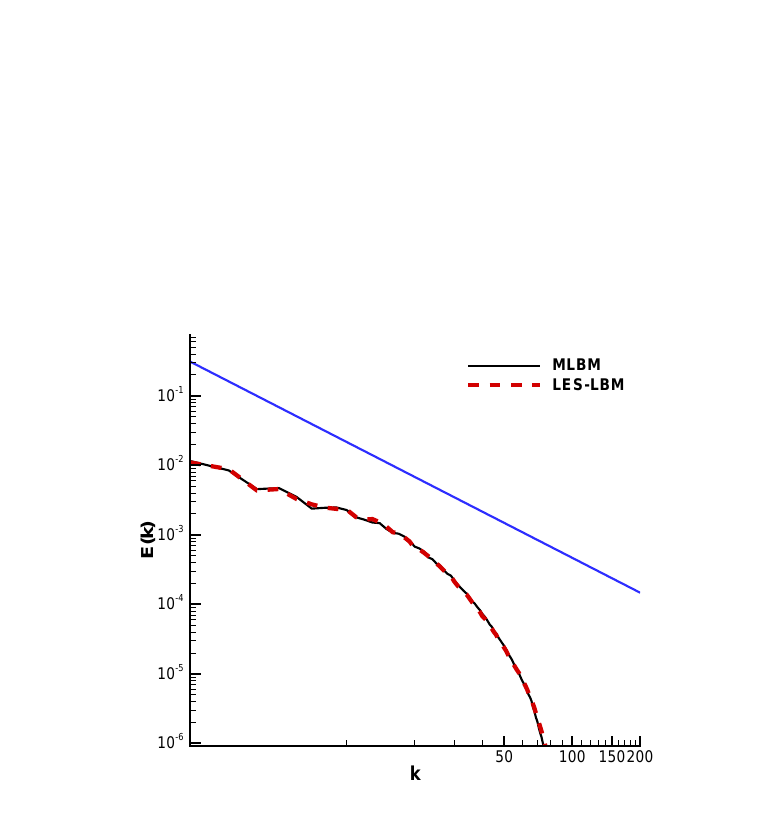
Fig. 11 Comparison of energy spectrum E(k) at t = 5, Re λ = 314 on mesh 256 3 . The straight line represents k − 5 3